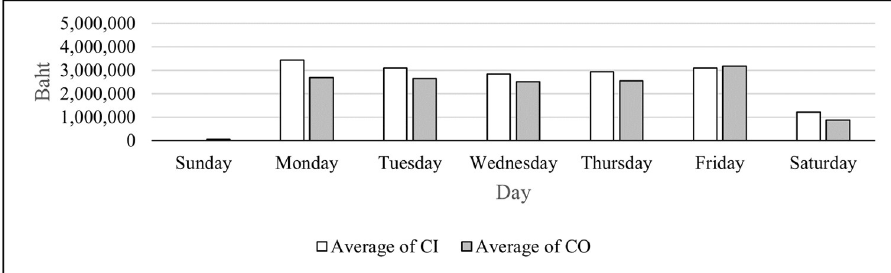
Fig 3. Average CI and CO for branches that open